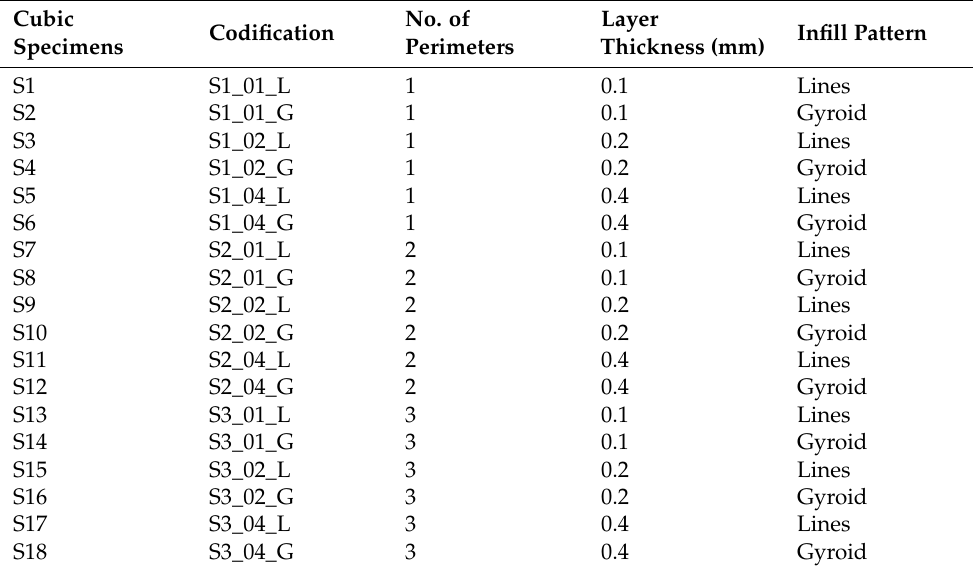
Table 2. 3D-printed specimens for compression